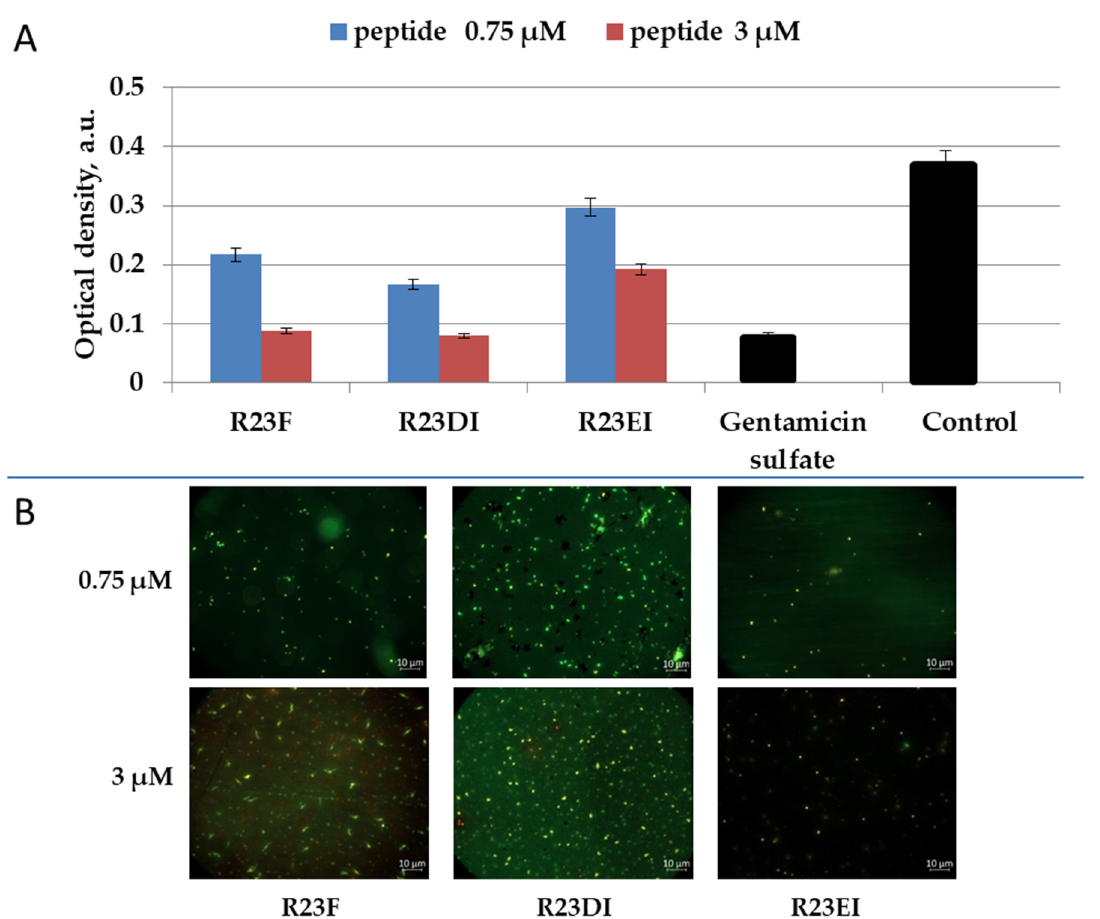
Figure 9. Antimicrobial effect of peptides on MRSA cells (ATCC 43300 strain) after one day of co-incubation ( A ). Fluorescence microscopic images of MRSA cells (ATCC 43300 strain) treated with peptides R23F, R23DI, and R23EI ( B ). A gentamicin sulfate concentration of 1700 μ M was used as a positive control for the antimicrobial effect. Bacterial cells stained with SYTO 9 and propidium iodide, but fluorescence signal of SYTO 9 is visible only since the cells are not dead, but growth of bacterial cells is inhibited. The experiments were performed in two replicates. The results were expressed as the mean ± standard deviation (M ± SD).